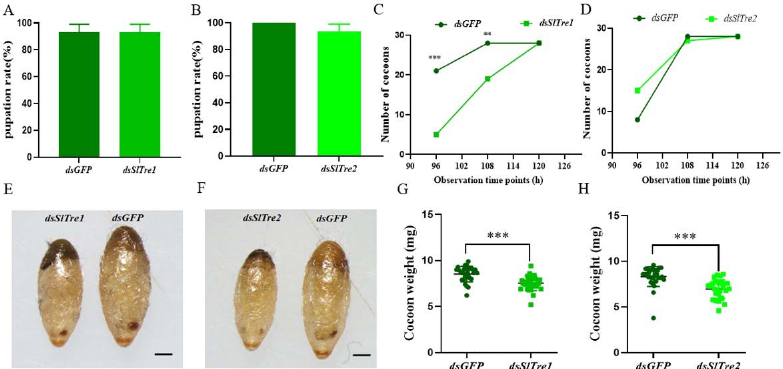
Figure 7. The pupation rate, duration from egg to cocoon, and morphology and weight of cocoons of parasitic wasp offspring egressed from parasitized S. litura larvae after they were knocking down SlTre1 or SlTre2 . Effect of silencing SlTre1 or SlTre2 on the pupation rate ( A , B ), durations from egg to cocoon ( C , D ), morphology of cocoons ( E , F ), and cocoon weight ( G , H ) in parasitized S. litura larvae. Significant differences were compared using ANOVA or chi-square test (for the data of duration from egg to cocoon). Significant differences are indicated by asterisks (** p < 0.01; *** p < 0.001; ns: no significant differences, Table S4); Scale bars in ( E , F ): 1 mm.